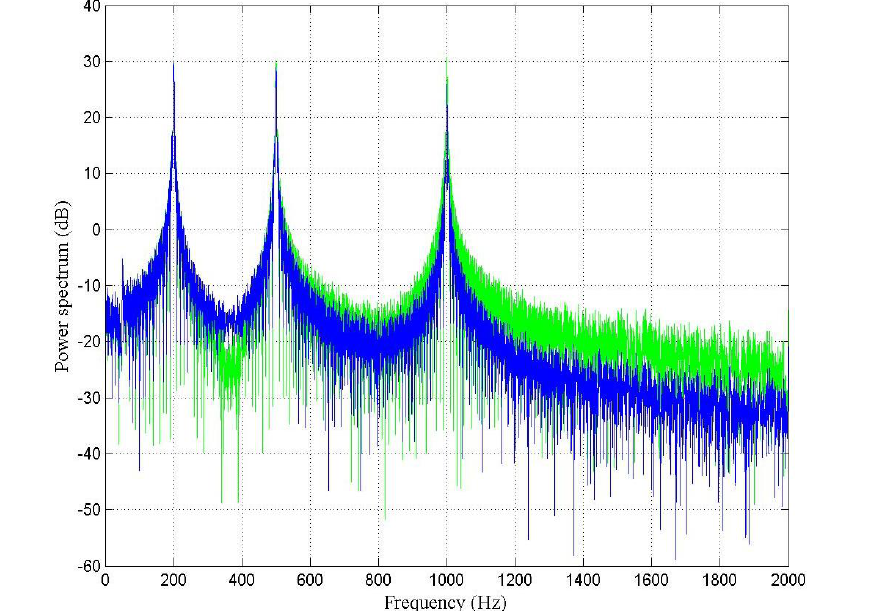
Figure 7. Power spectrum (dB) of the output signal before (green) and after (blue) filtering by using the LMS adaptive filter.